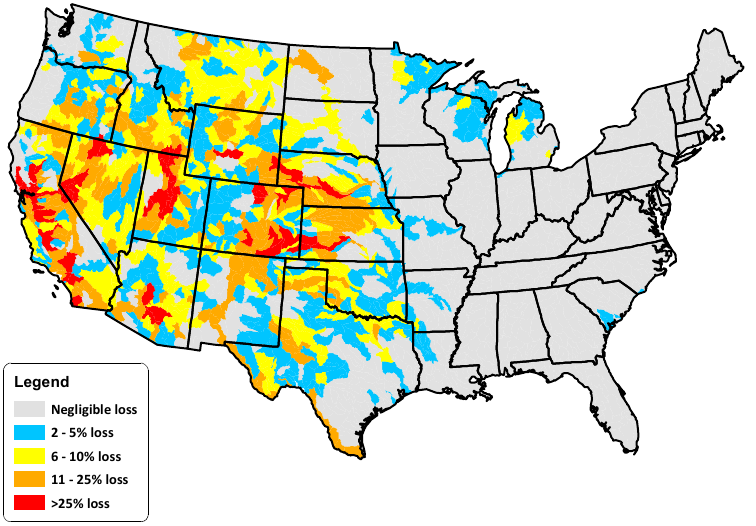
Figure 4. Summer streamflow depletion in the Western US due to water footprints of production, specifically those related to irrigated agriculture. Predictive ecological models estimate that some basins will lose over 25% of native fish species due to streamflow depletion caused by large water withdrawals and consumption. This figure is taken from Richter et al. [20] and is for the period